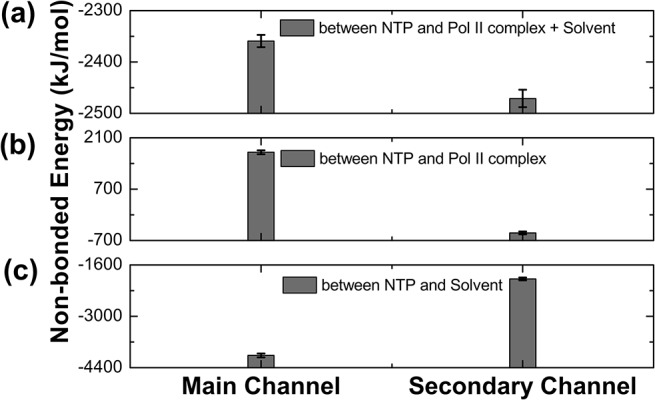
Non-bonded interactions NTP experiences revealed by MD.The plots compare the energetic contribution of non-bonded interactions (electrostatic + vdW) along the main channel and secondary channel for: (a) NTP and its environment (the Pol II complex and solvent); (b) NTP and the Pol II complex; and (c) NTP and solvent. In these calculations, the Pol II complex includes the protein and nucleotides. The solvent contains water molecules together with the counter-ions. The results shown in (a) are the total contributions from the Pol II complex (shown in (b)) and the solvent (shown in (c)) (see Methods).